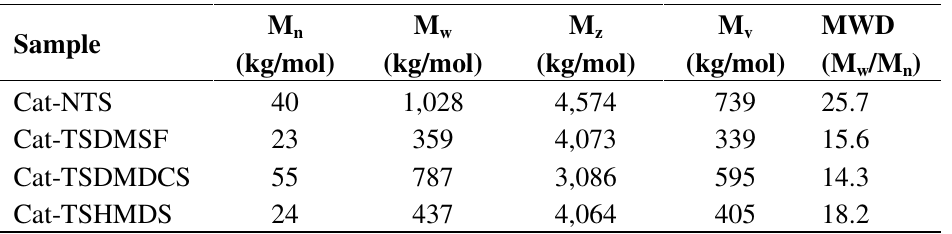
Table 3. Molecular weights and their distribution of polymers obtained from different catalysts.